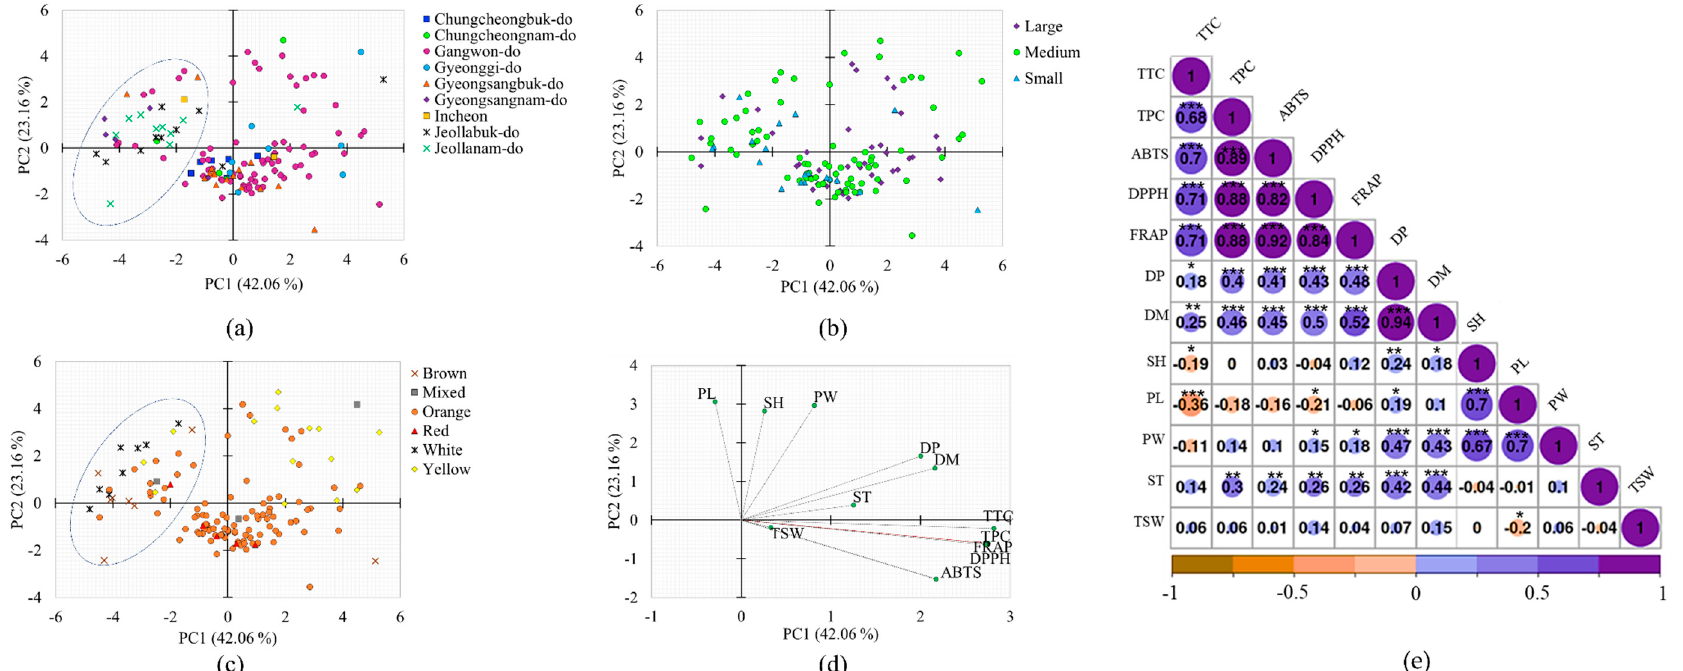
Figure 4. Score plot of sorghum landraces according to collection area ( a ), seed weight ( b ) and seed color ( c ). Loading plot of variables ( d ) from PCA, and correlation matrix of quantitative variable ( e ). *** p < 0.001, ** p < 0.01, * p < 0.05. DM: Days to maturity; DP: Days to panicle; PL: Panicle length; PW: Panicle width; SH: Stem height; ST: Stem thickness; TSW: Thousand seed weight. Full names for the remaining abbreviations can be seen in Figure 3 footnotes.